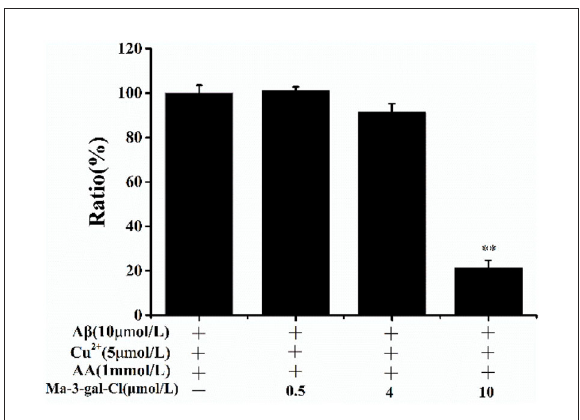
system, and the cell toxicity from A β (1–42) toxic aggregates.